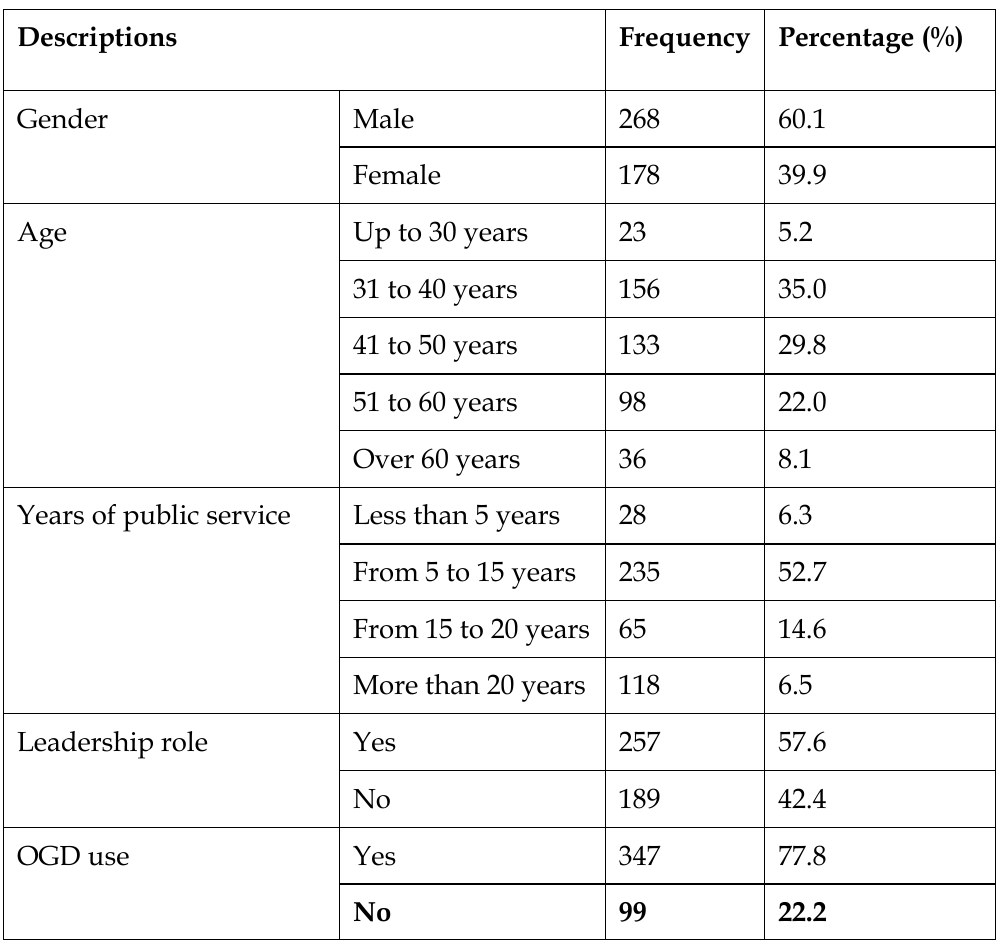
Table 2: Sample profile